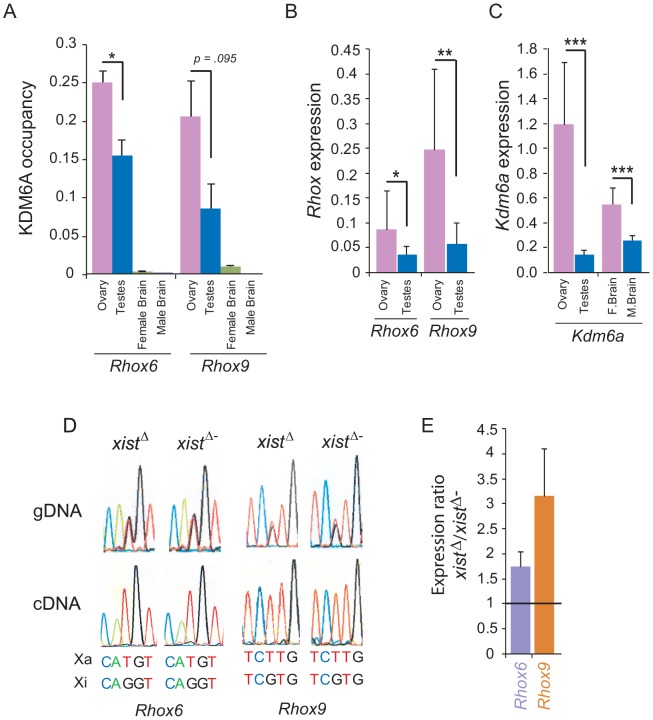

Rhox6 and 9 expression and KDM6A occupancy are high in ovary where the genes are imprinted.(A) Rhox6 and 9 have significantly higher expression in mouse ovary than in testis, based on re-analyses of published expression array data for 14 testis and 12 ovary specimens (*p<0.05, **p<0.001). Expression normalized to array mean (see also Figure 1C). (B) KDM6A occupancy measured by ChIP-qPCR at the 5′end of Rhox6 and 9 is higher in ovary than in testis, and is very low to undetectable in brain where these genes are not expressed [19]. Occupancy levels were normalized to input fractions. (C) Kdm6a has high expression in female tissues especially ovary based on analyses of published expression array data (***p<0.0001) (see also Figure 1F). (D) Rhox6 and 9 are expressed from the maternal allele only in ovary because of imprinting. DNA sequence chromatograms of gDNA and RT-PCR (cDNA) products derived from ovary from female F1 mice obtained by mating M. spretus males with C57BL/6J females with or without an Xist mutation (XistΔ and XistΔ−). SNPs to distinguish Rhox6 and 9 alleles on the active X (Xa) and on inactive X (Xi) are indicated below. In ovary from both XistΔ and XistΔ− mice the gDNA shows heterozygosity at the SNPs while the cDNA shows only the maternal allele, consistent with paternal imprinting. (E) By qRT-PCR Rhox6 and 9 are more highly expressed in ovary from XistΔ mice in which the maternal X chromosome is expressed in all cells, compared to XistΔ− mice in which there is random X inactivation (1.7-fold and 3-fold, respectively), suggesting that Rhox6 and 9 are silenced by X inactivation. Values represent the expression ratio between XistΔ and XistΔ− ovaries.